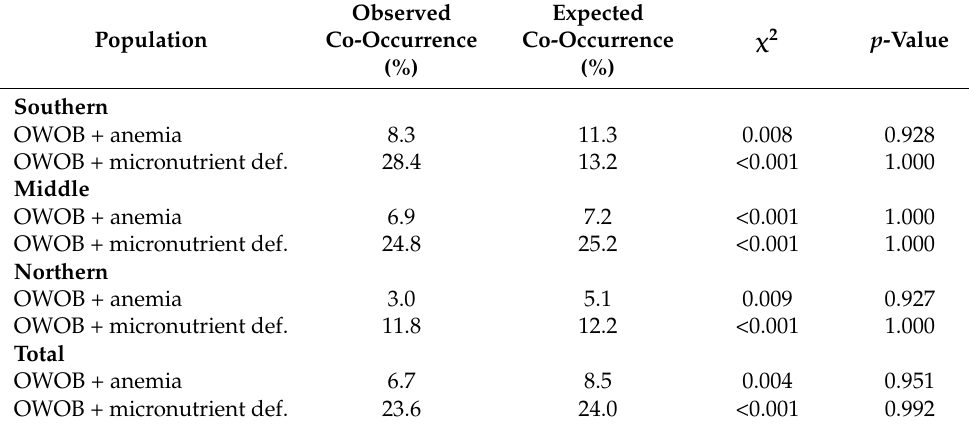
Table 3. Comparison of the observed co-occurrence of overweight/obesity with anemia and over- Ghana with their expected